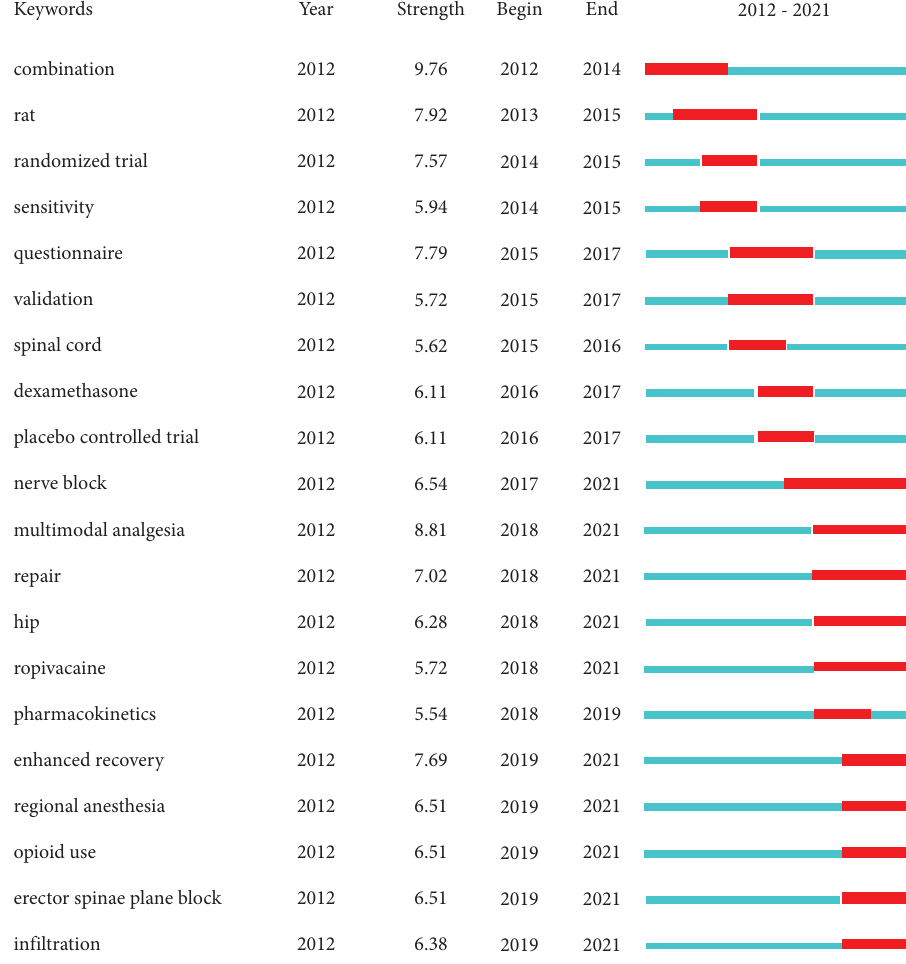
Figure 10: Te 20 keywords from publications on acute postsurgical pain show the strongest bursts of citations. Notes: the lengths of red bursts on the blue timelines are proportional to their